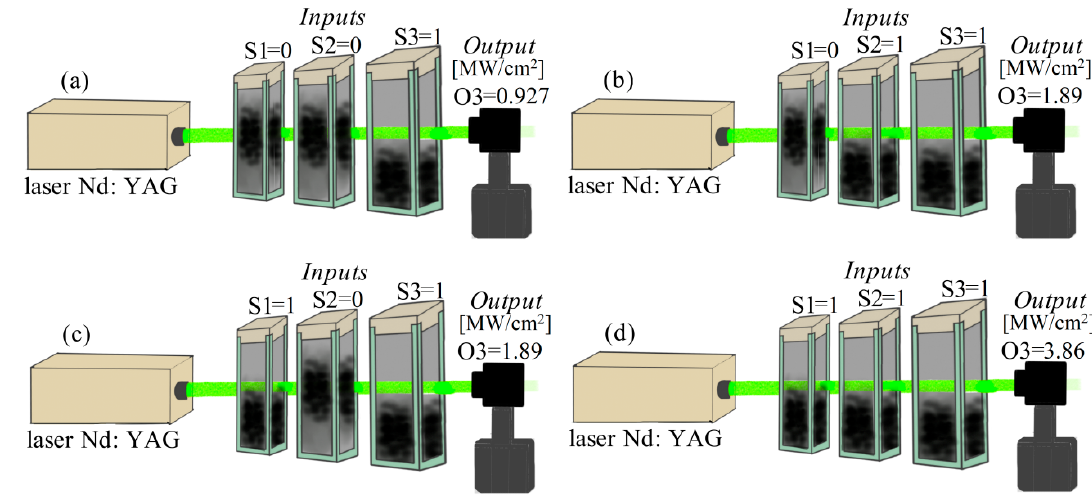
Figure 7. Experimental setup of the probabilistic gate in an AND configuration controlled by the particle position probabilities. The laser beam energy is absorbed by the CNTs position. ( a ) S1 = 0, S2 = 0; S3 = 1, O3 = 1 with 0.927 MW / cm 2 , ( b ) S1 = 0, S2 = 1; S3 = 1, O3 = 1 with 1.89 MW / cm 2 , ( c ) S1 = 1, S2 = 0; S3 = 1, O3 = 1 with 1.89 MW / cm 2 ( d ) S1 = 1, S2 = 1; S3 = 1, O3 = 0 with 3.86 MW / cm 2 . The logical value 1 was assigned to an optical irradiance lower than 2 MW / cm 2 . Otherwise, the logical value is 0.